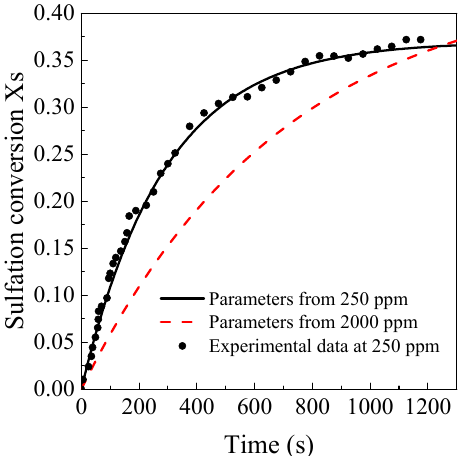
Figure 12. Predicted sulfation conversion at 250 ppm using empirical parameters from different SO 2 concentration using Equation (6) (Shengzhou Limestone, 17.9 μ m).